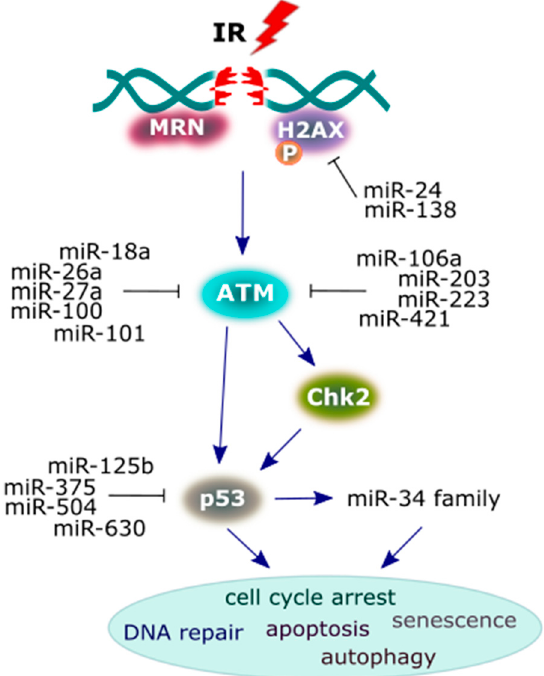
Figure 4. A scheme presenting the major proteins of the DNA damage response (DDR) signaling breaks (DSBs) by irradiation, the reaction initiates protein components, such as sensors (MRN/H2AX),